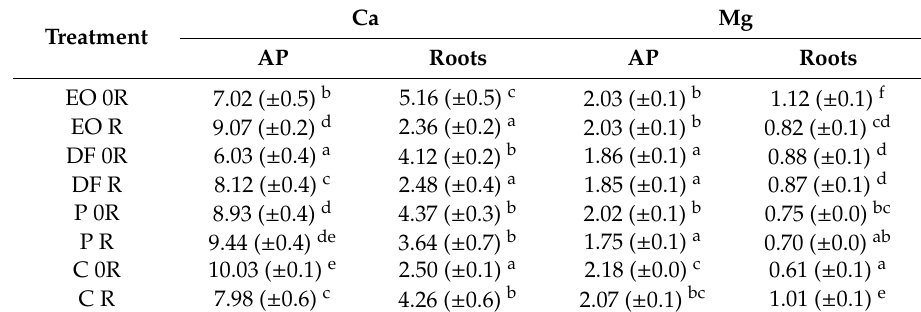
Table 4. The e ff ect of petroleum-derived substances and bioremediation on the content of selected nutrients in the aboveground parts (AP) and roots of Vicia faba L. (g kg − 1 ).